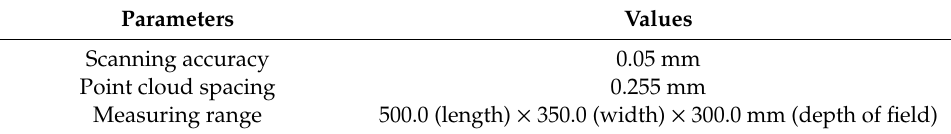
Table 3. Specifications of FARO Cobalt Array Imager